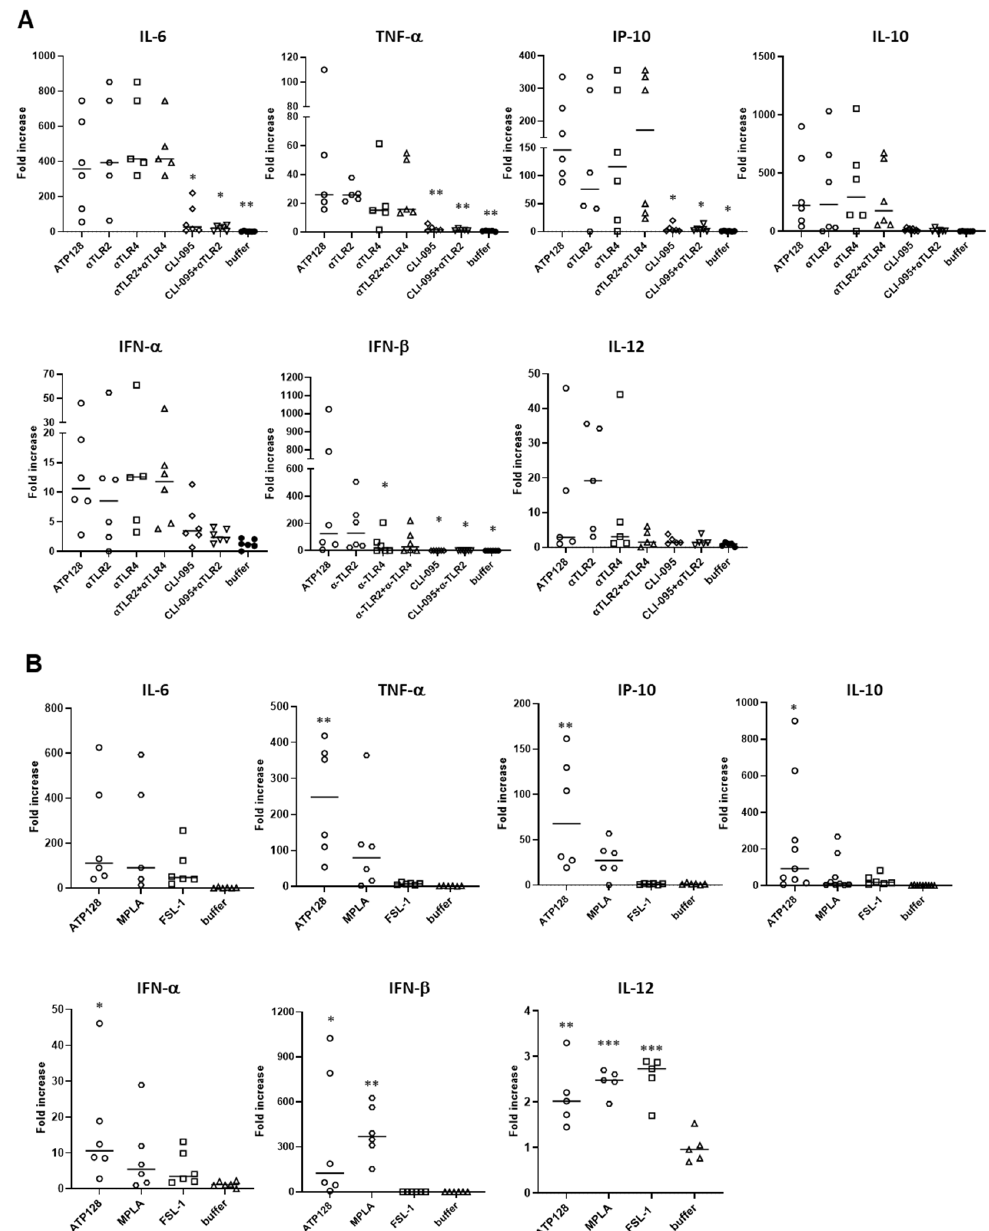
Figure 6. ATP128 induces cytokines release upon activation of both the NF- κ B and IRF3 pathways. ( A ) Human moDC were pre-treated with anti-TLR2, anti-TLR4, or CLI-095 for 1 h, then stimulated for 6 h or 24 h (for IL-12) with 300 nM ATP128. Cell supernatants were collected to assess the signature of cytokines secretion upon ATP128 stimulation through a multiplex cytokine assay. The values in the graphs represent the fold increase of the stimulated samples to the medium. Each shape is representative of a different buffy coat. Represented are the cytokines that are mainly induced upon stimulation. Values were compared via one-way ANOVA test to the sample stimulated with ATP128 FL. ( B ) Human moDC were incubated for 6 h or 24 h (for IL-12) with 300 nM ATP128 or 600 nM MPLA or 1 ng/mL FSL-1. Cell supernatants were collected to assess the signature of cytokines secretion through a multiplex cytokine assay (same as above). The values in the graphs represent the fold increase of the stimulated samples to the medium. Each shape is representative of a different buffy coat. Represented are the cytokines that are mainly induced upon stimulation. Values were compared via one-way Anova test to the sample treated with the buffer (negative control *** p -value < 0.001, ** p -value < 0.01, * p -value < 0.05.